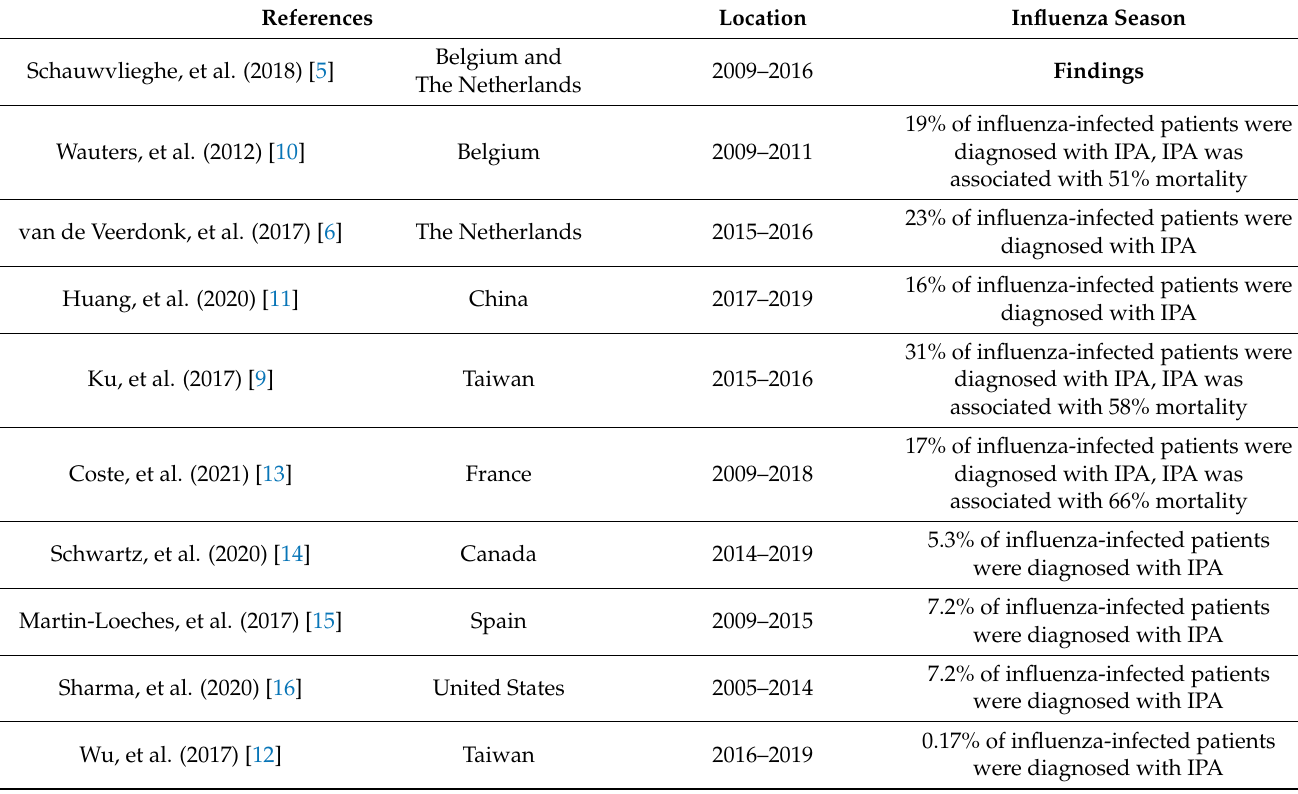
Table 1. Summary of studies evaluating post—influenza